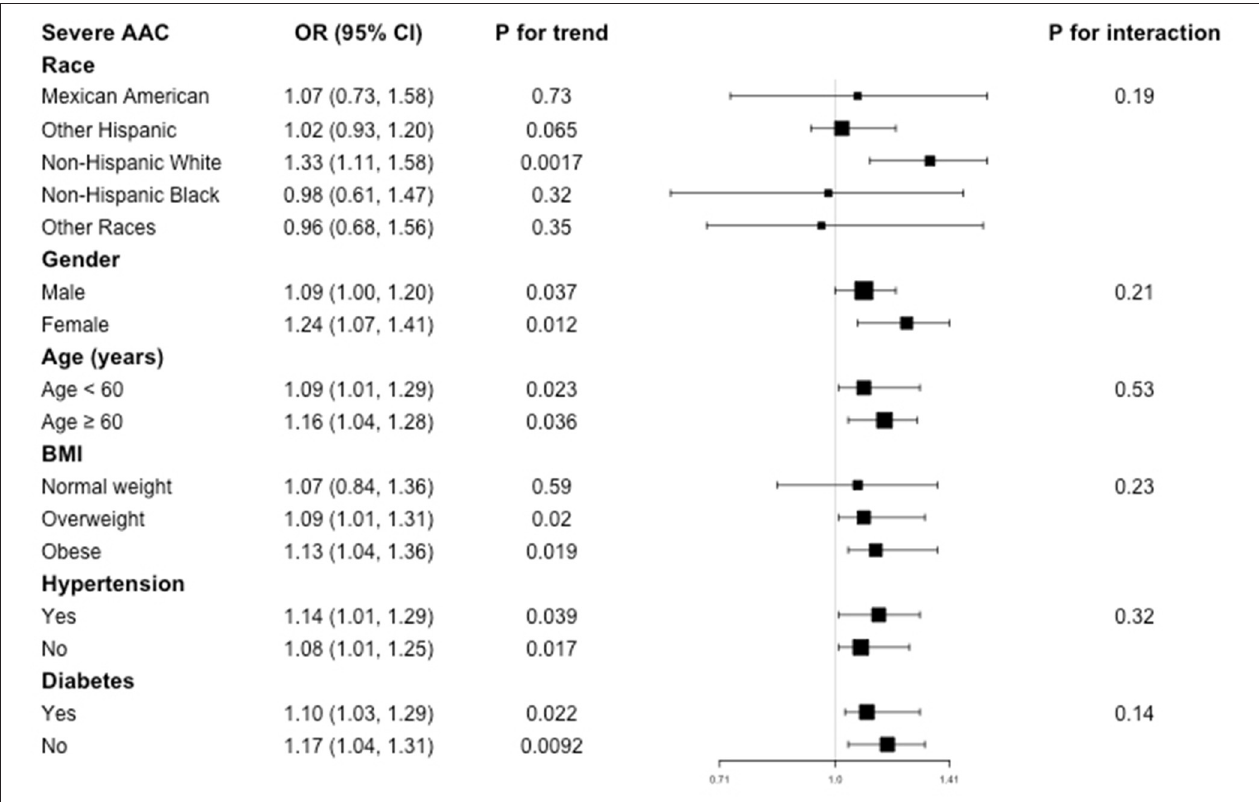
FIGURE 3 | Subgroup analysis for the association between BLL and severe